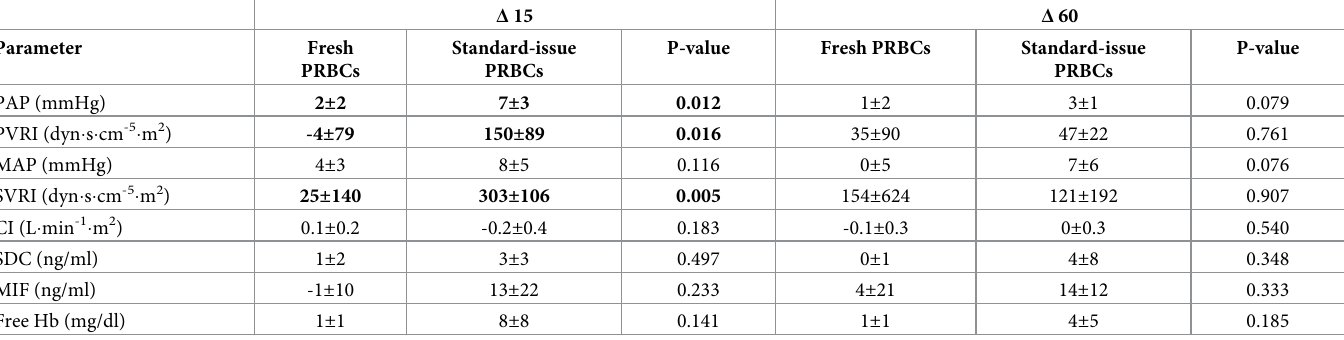
Table 3. Changes of hemodynamic and laboratory parameters at 15 and 60 min following start of transfusion. Data are depicted as mean ± standard deviation. P-val- ues (Welch’s t-Test) indicate differences among patients receiving fresh and standard-issue PRBCs. Statistically significant data are printed bold. Abbreviations: Δ 15, change in parameter during transfusion; Δ 60, change in parameter within the first 60 minutes after starting transfusion; CI, cardiac index; Hb, hemoglobin; MIF, macro- phage migration inhibitory factor; PAP, pulmonary arterial pressure; PRBCs, packed red blood cells; PVRI, pulmonary vascular resistance index; SDC, syndecan-1; SVRI, systemic vascular resistance index; MAP, mean arterial pressure; CI, cardiac